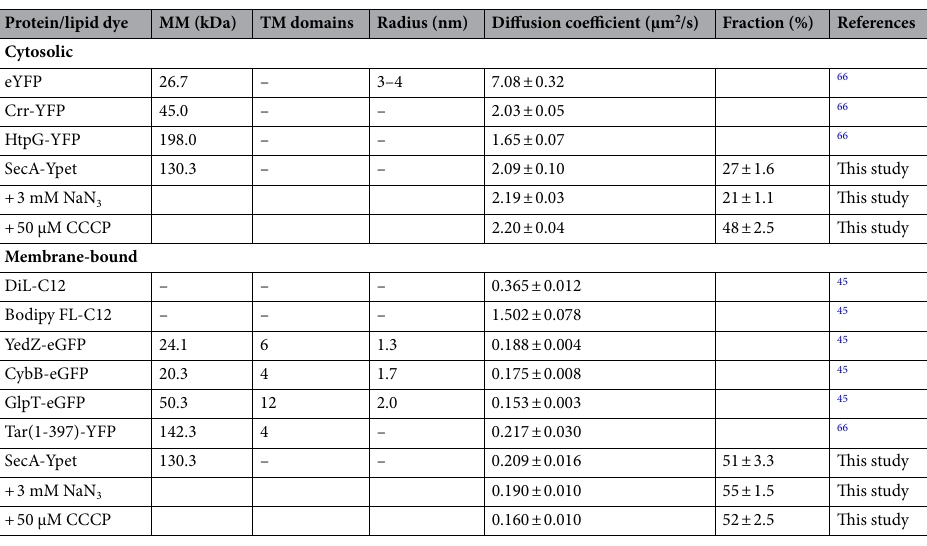
Table 2. Diffusion data of cytosolic and membrane(-bound) proteins and probes. MM molecular mass. TM domains Transmembrane